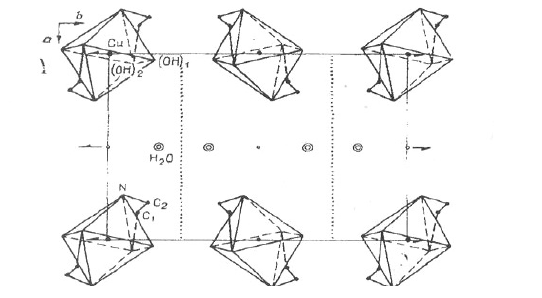
Figure 1. Projection of the structure on the xy plane